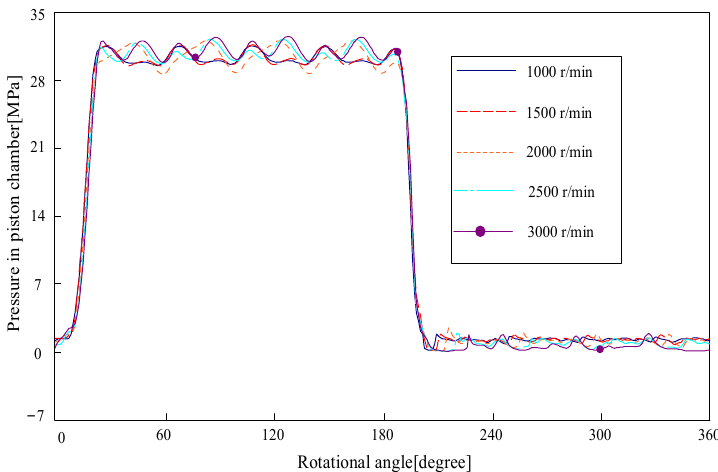
Figure 15. Pressure in the piston chamber with different rotational speeds.